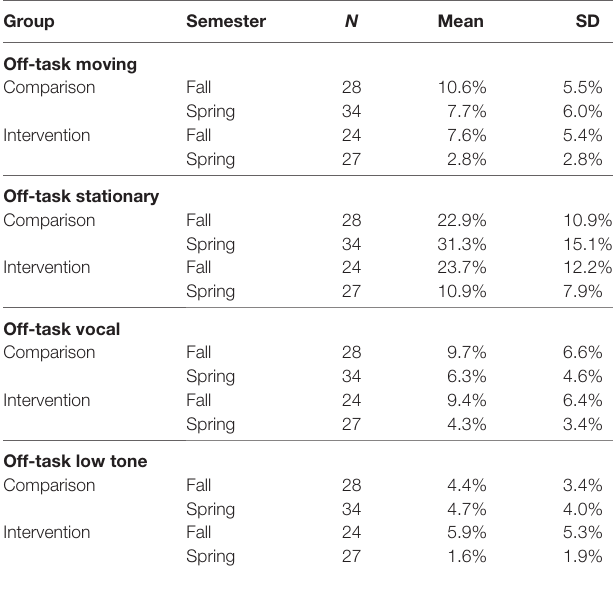
TaBle 2 | Means and SDs of percentage off-task type behavior by group and semester. group semester